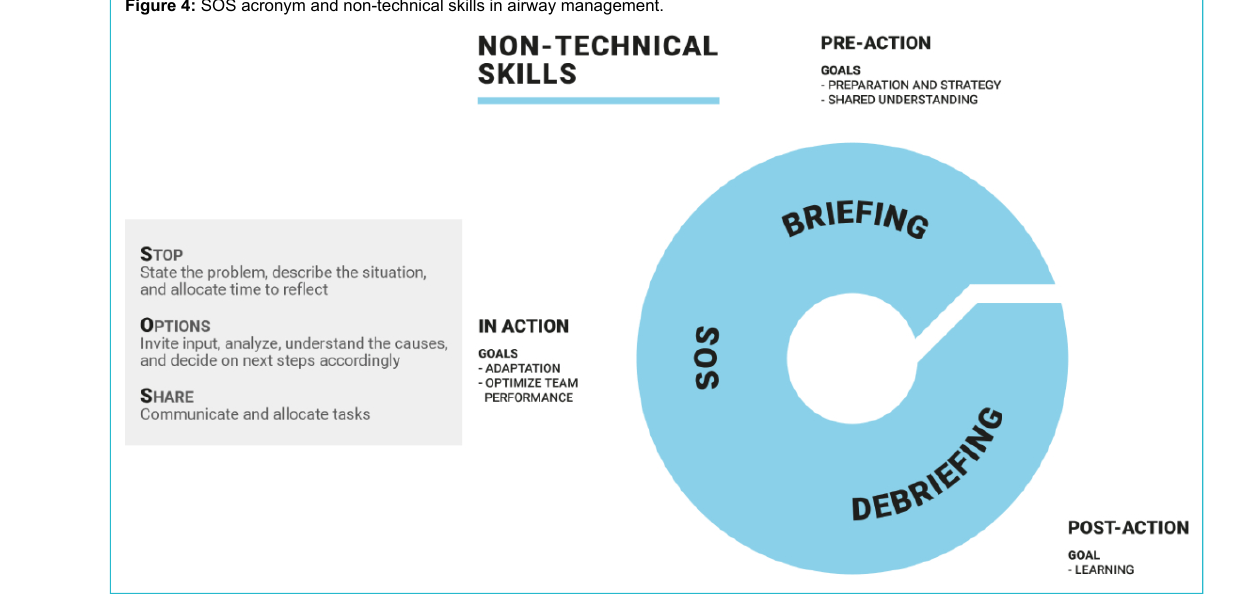
Figure 4: SOS acronym and non-technical skills in airway